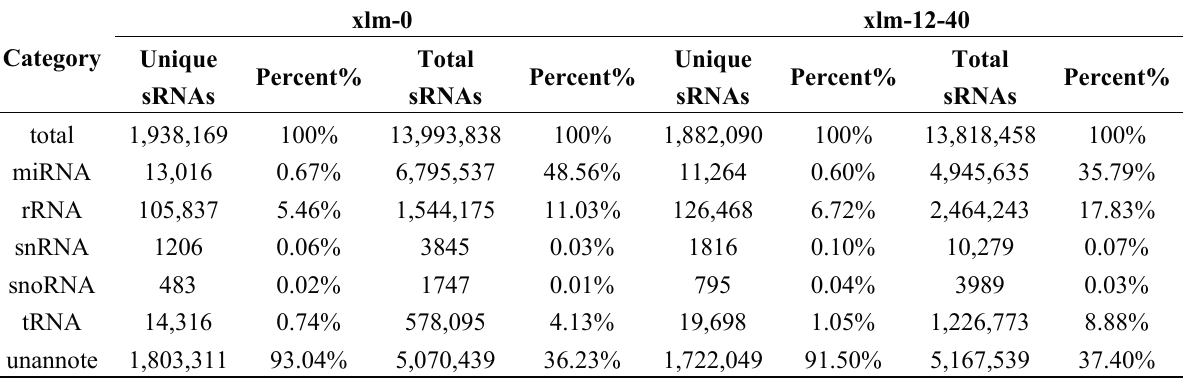
Table 1. sRNA category and statistics of P. acerifolia .